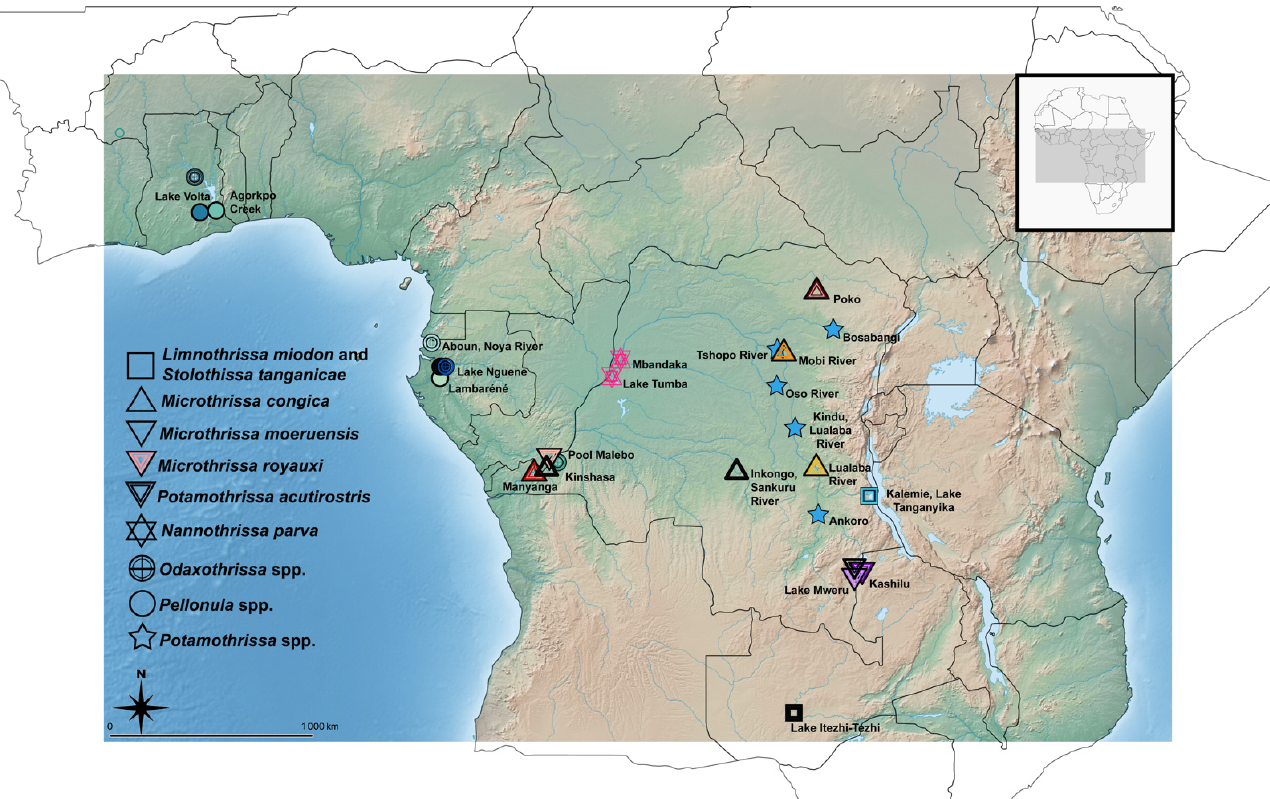
Figure 1. Overview of the sampling localities of freshwater African clupeid species examined for the presence of monogenean parasites as part of this study. Colours and signs denote parasite species, host species, and locality of origin displayed in the subsequent results of statistical analyses. Table 1. Sampling details of the pellonuline host specimens investigated.